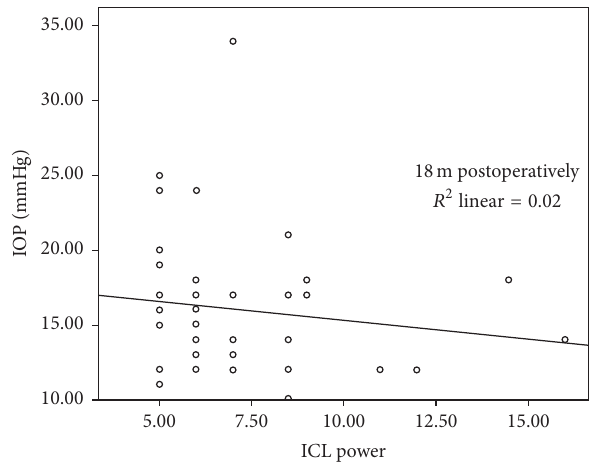
Figure 4: Correlation between mean ICL power and IOP 18 months postoperatively.